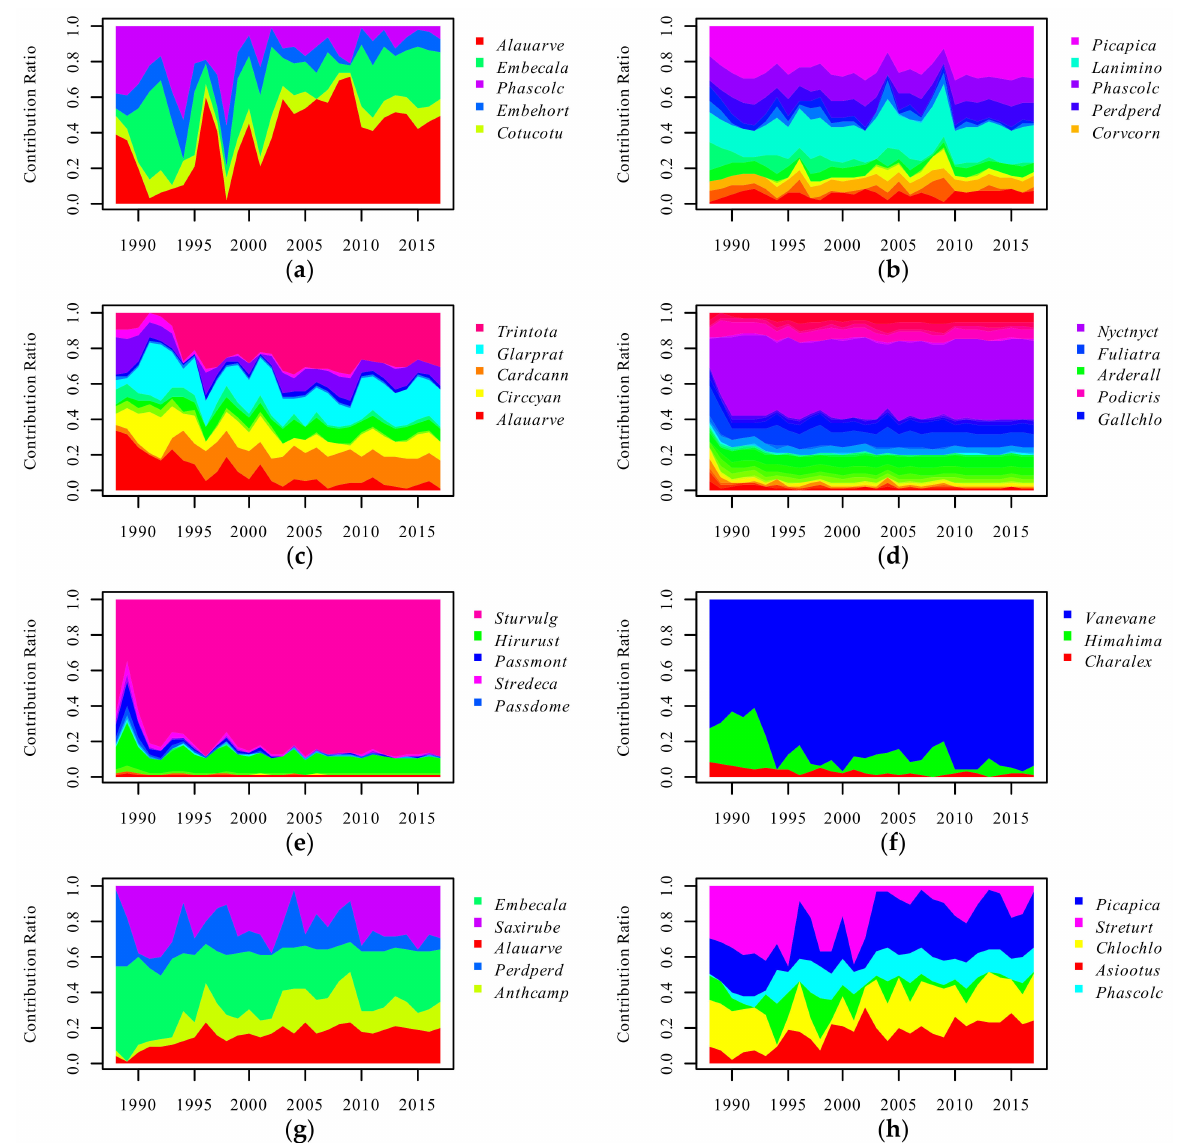
Figure 4. Contribution ratios of each species obtained after analyzing the turnover of bird communi- ties in the Molochna River valley for the period (1988–2018). The top five species with the highest contribution ratio are stated in the legend: the abscissa is the order of years, the ordinate is